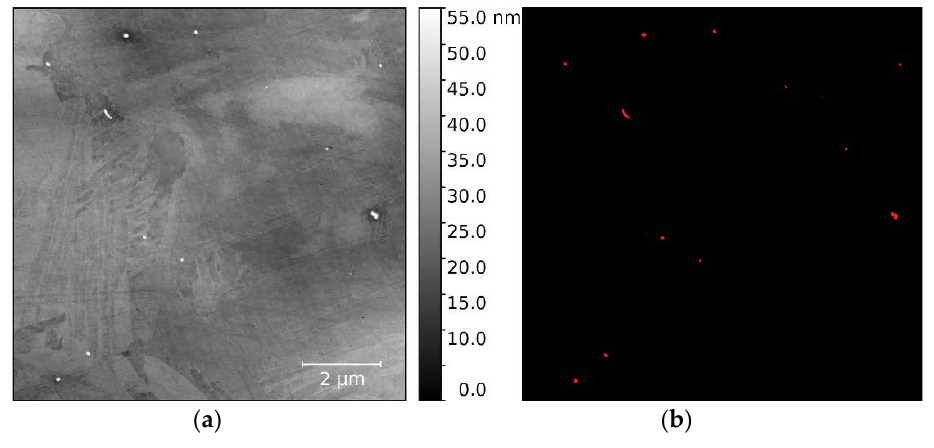
Figure 2. Maps of the two steps of the particle segmentation: ( a ) original AFM map; ( b ) segmented particles.